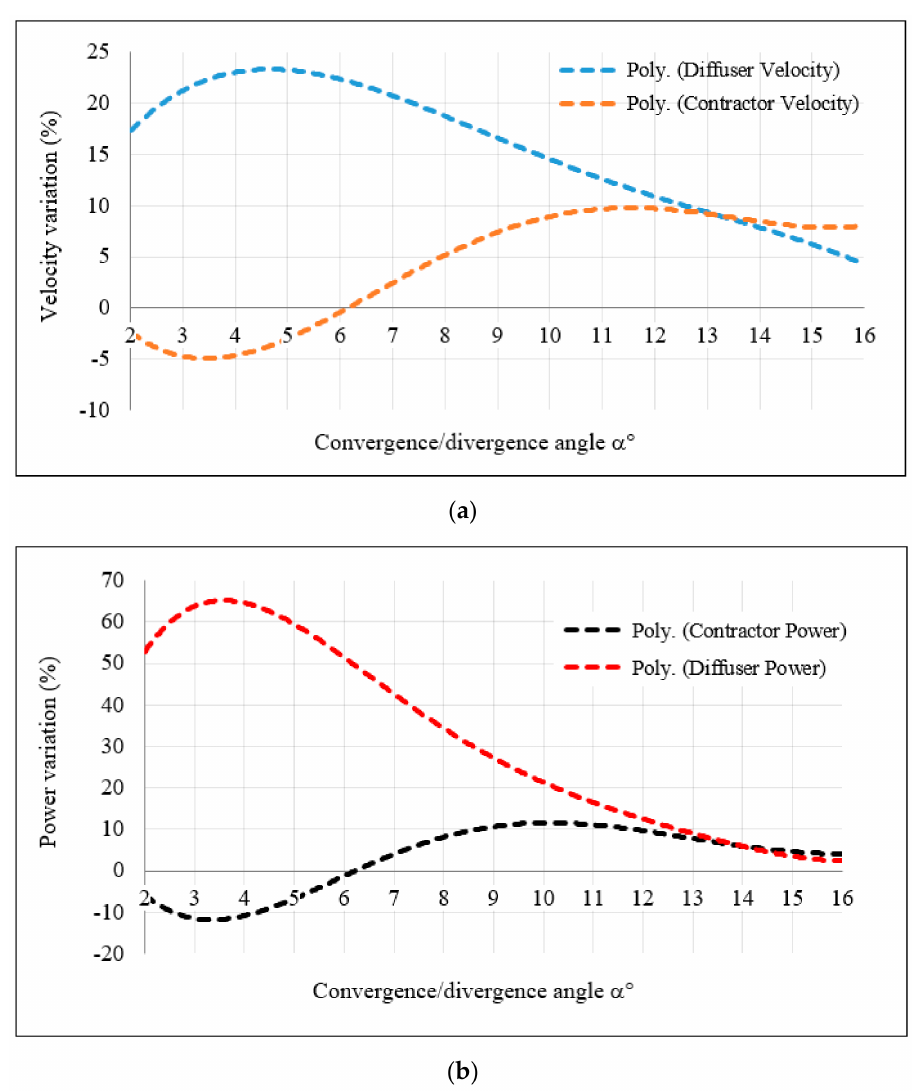
Figure 11. ( a ) The optimum velocity variation and ( b ) optimum power variation for the conical